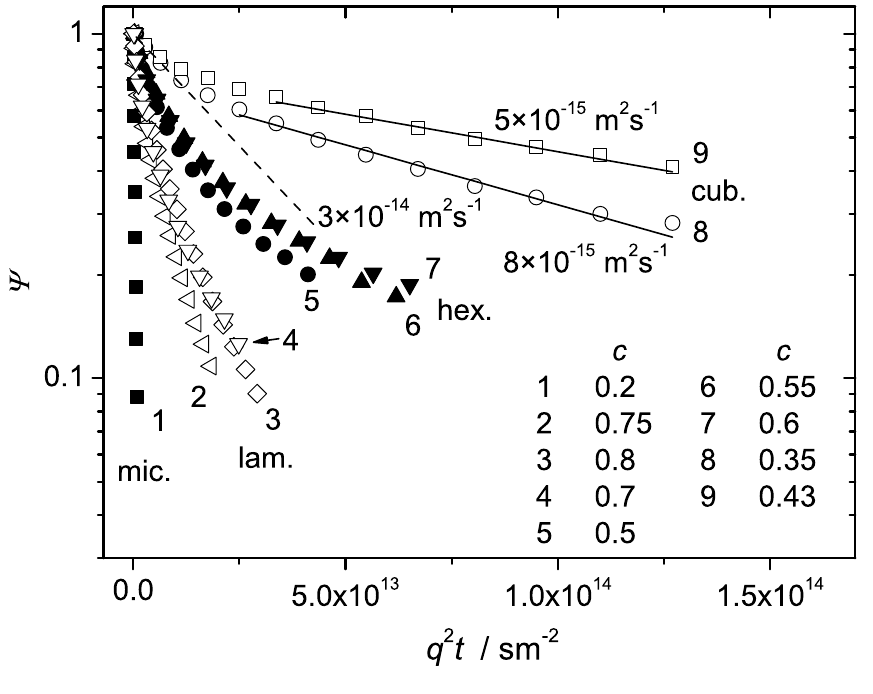
Figure 5. The normalized spin echo diffusion attenuations of the triblock copolymer P104 in water for different concentrations at T = 23 ◦ C. The polymer weight fractions for the curves 1–9 were 0.2, 0.75, 0.8, 0.7, 0.5, 0.55, 0.6, 0.35 and 0.43, respectively. The solid lines refer to the initial slopes of the slow components. The dashed line is the guide for the eye.